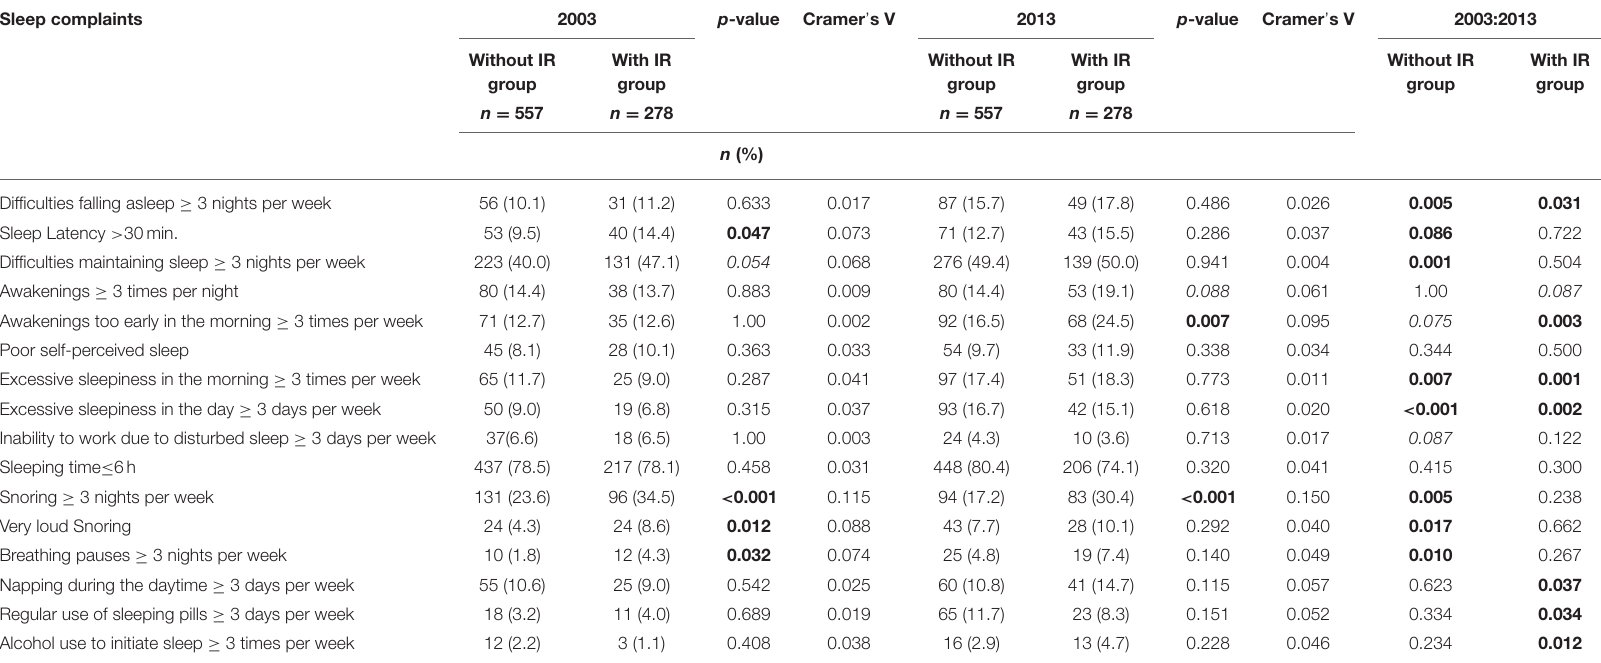
IR, insulin resistance; p-value of probability for comparison between groups (p < 0.05 in bold); SD, standard